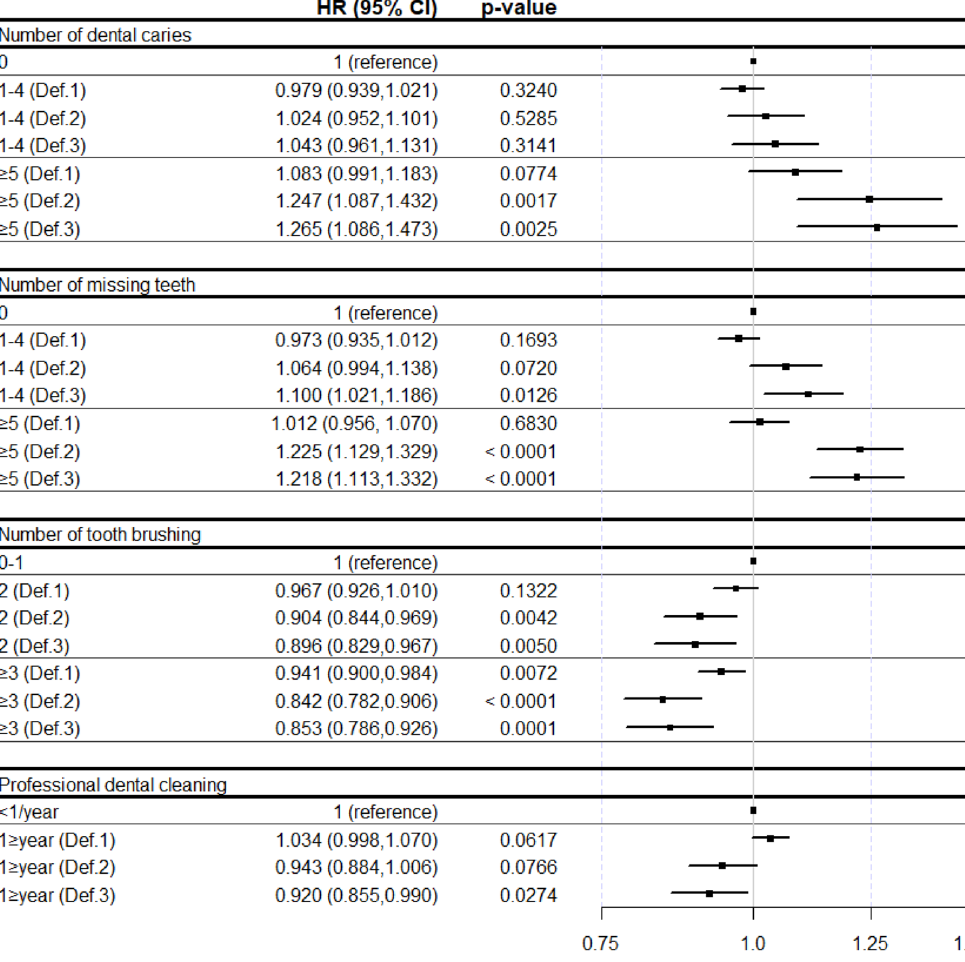
Figure 3. Hazard ratio and 95% confidence interval for incidence of pneumonia according to oral health status and oral hygiene behaviors with different definitions of pneumonia. HR, hazard ratio; CI, confidence